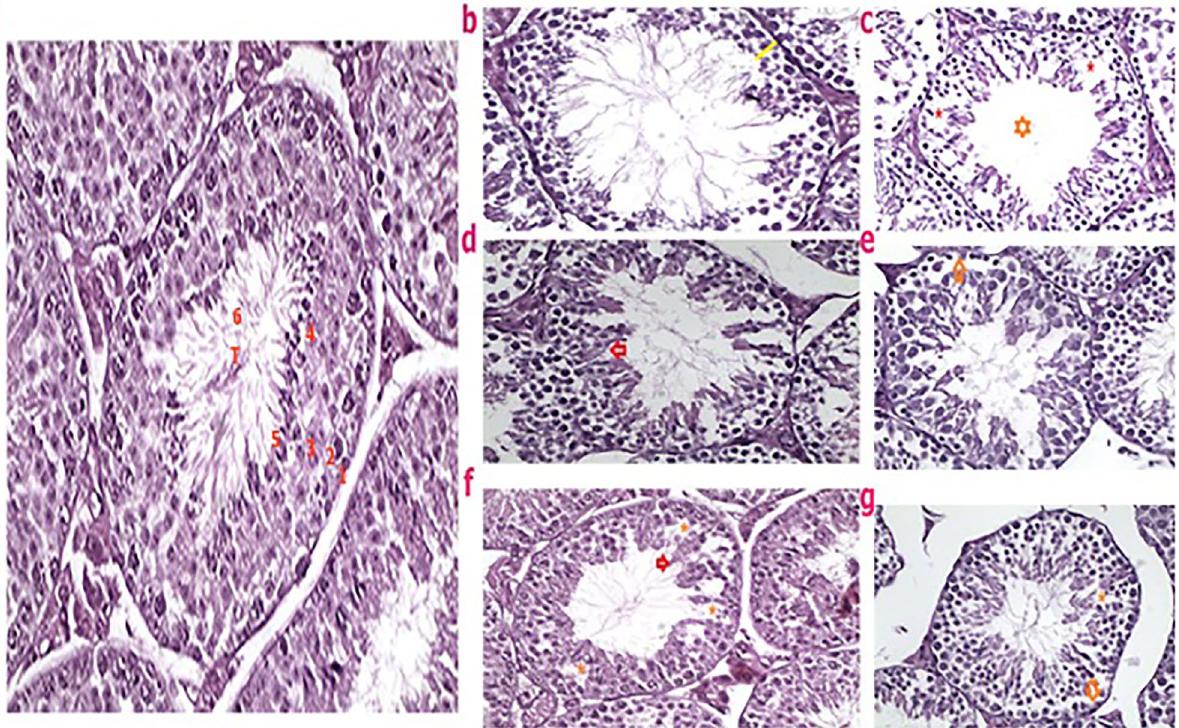
Figure 1. Photomicrographs of testicular sections of adult pups of different experimental groups submitted to the hematoxylin/eosin Y staining. Normal seminiferous tubules (T) with clear lumen and perfect spermatogenesis contained of various germ cells of mice from Vehicle group were observed ( a ). The large quantity of germinal lineage cells in a normal arrangement of cellular types including of spermatogonia (1), primary spermatocyte (2), secondary spermatocyte (3), round spermatid (4), attached sperms (5), released sperm within lumen was observed. Testis of a nicotine-exposed mice ( b – e ) showing severe deteriorating change and atrophy of seminiferous tubules ( b , yellow line), absence ( c , orange star) or reduction ( d ) of the sperm cells within the lumen of some seminiferous tubules with some degenerative alterations alike vacuoles ( c , red stars). Note, the absence of germ cells resulting in partial depletion of the seminiferous epithelium and germinal cells atrophy ( d , red arrows), sloughing germinal epithelium ( d , red arrow) and detached spermatogenic cells from basement membrane ( e , orange arrow). Testicular sections obtained from F1 pups of dams exposed to either ethanol ( f ) or concurrent nicotine and ethanol ( g ) showing the restoration of spermatogenic cells in most seminiferous tubules, a few sperm cells in the lumen with several vacuoles in the germinal epithelium (stars).